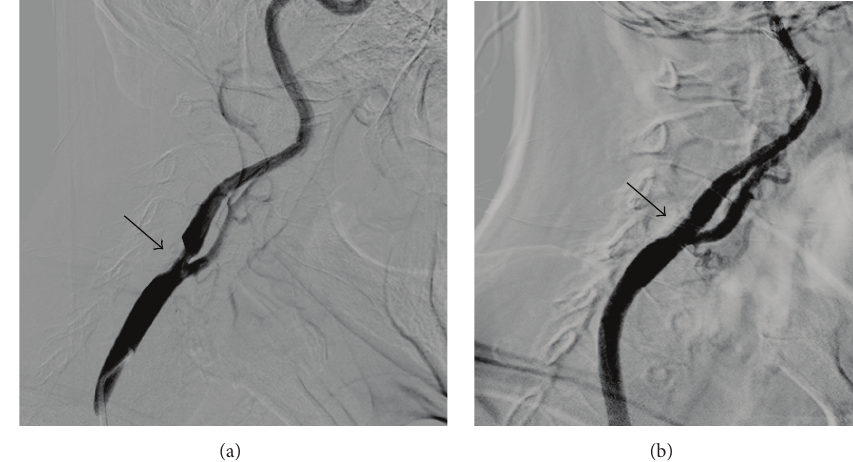
Figure 2: Selective right carotid angiography confirmed critical stenosis (black arrows) in the right internal carotid artery at the bifurcation level (a). Successful carotid stent placement was performed without residual stenosis